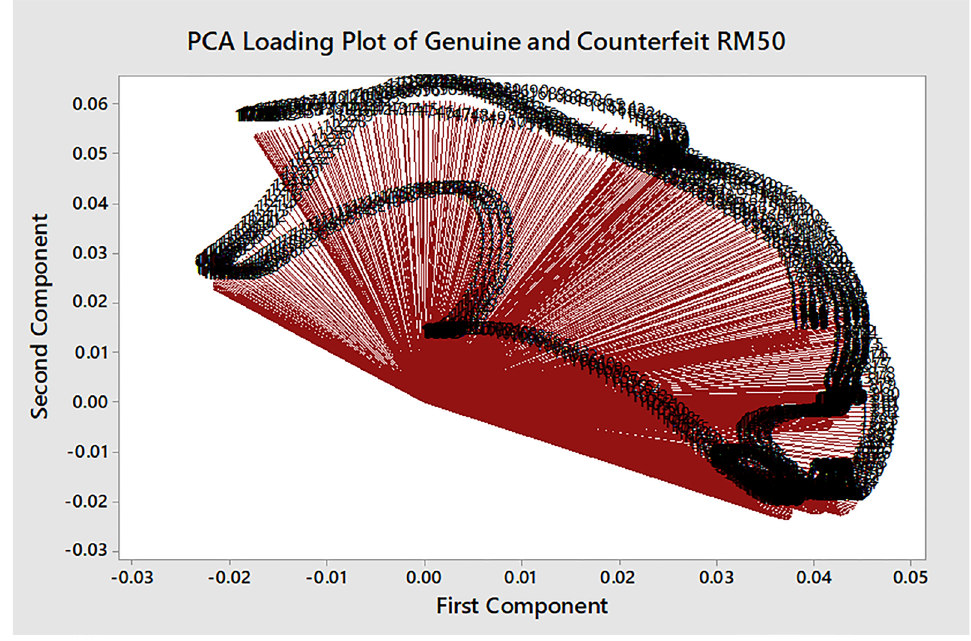
Figure 15. The PCA Loading Plot of Genuine (GE) and Counterfeit (CS) RM50 Samples. This figure was generated using Minitab version 17 (Minitab Inc., PA, USA; https:// www. minit ab. com).